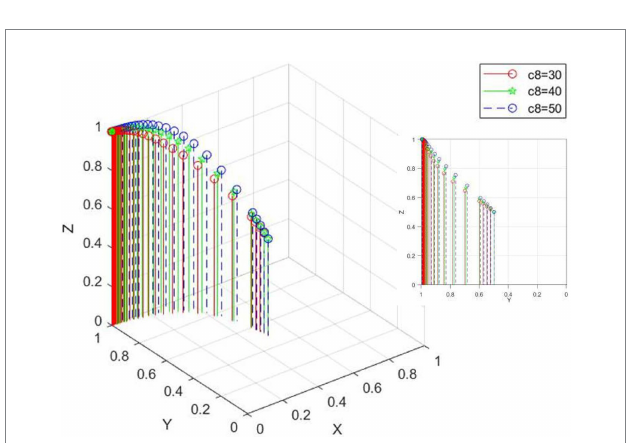
FIGURE 14 Impact map of government failure costs (Scenario